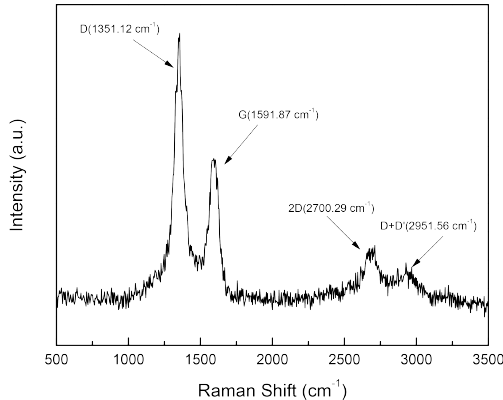
Figure 6: Raman spectrum for bulk-NCG thin film grown on 300 nm thick thermal SiO